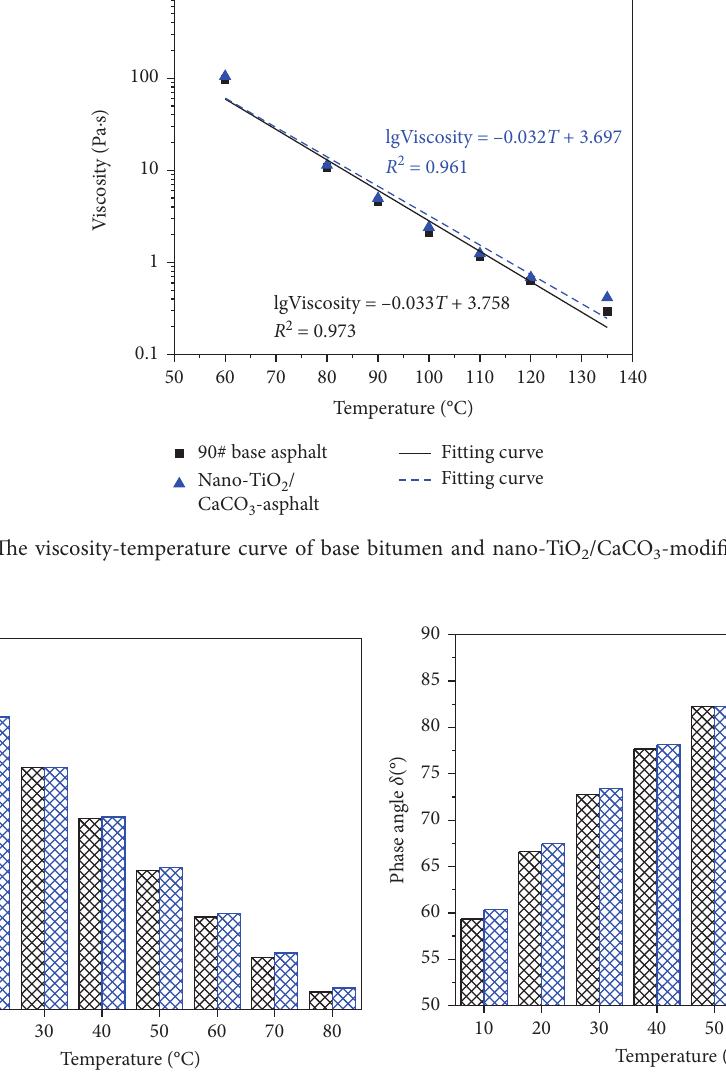
Figure 6: DSR results versus temperatures. (a) G ∗ and (b) δ